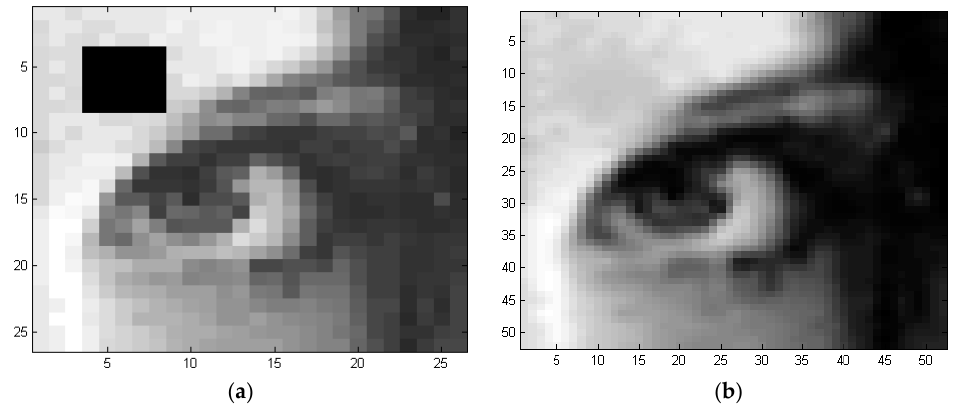
Figure 13. Reconstruction of a poor image: ( a ) Defected and distorted image; ( b ) Automatic denoising and reconstruction.